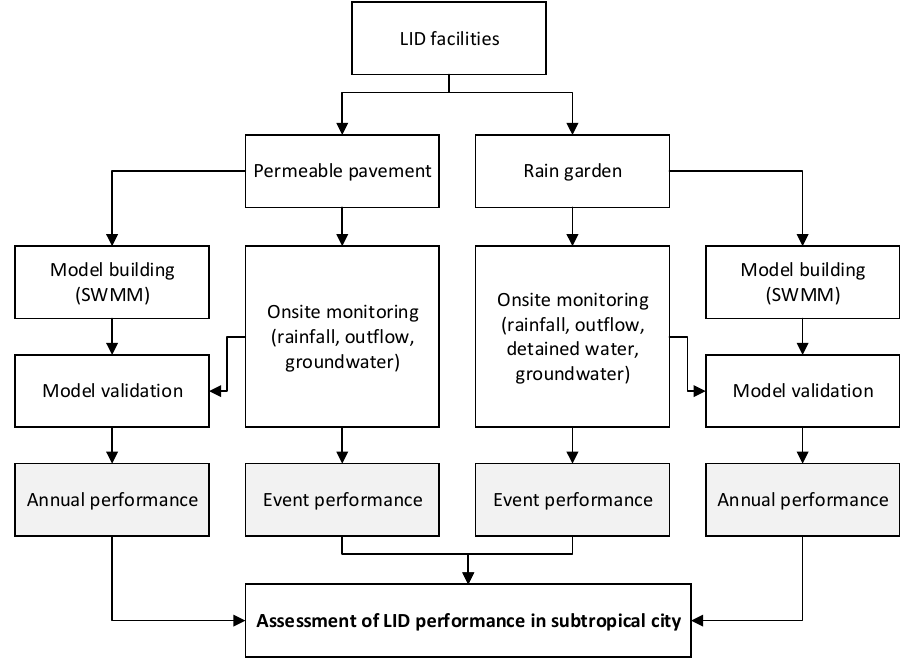
Figure 1. Flowchart of this